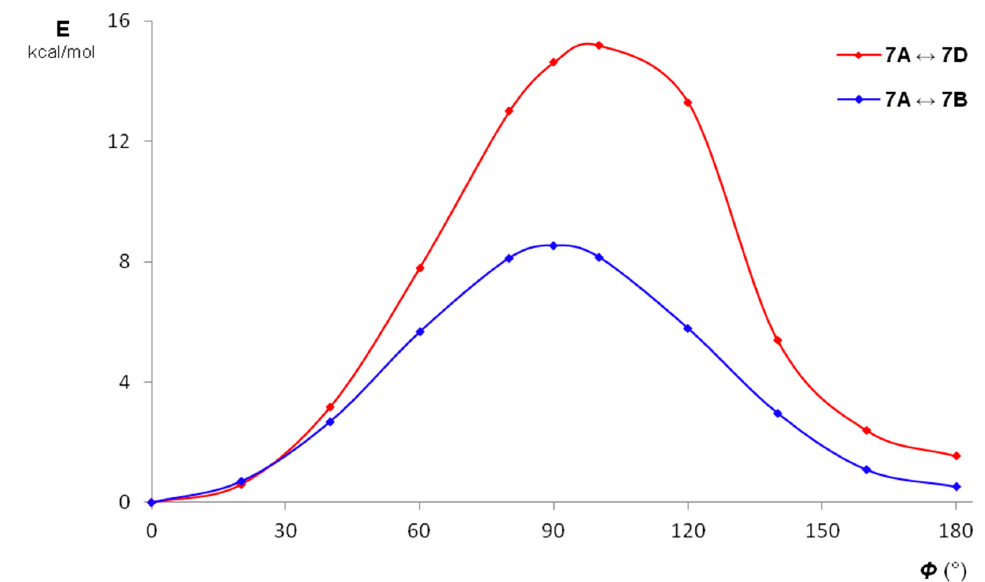
Figure 3. Profiles of the total energy difference with respect to the 180 ° rotation of single bonds C3–C4 ′ ( 7A ↔ 7B ) and C6 ′ –N1 ′′ ( 7A ↔ 7D ).